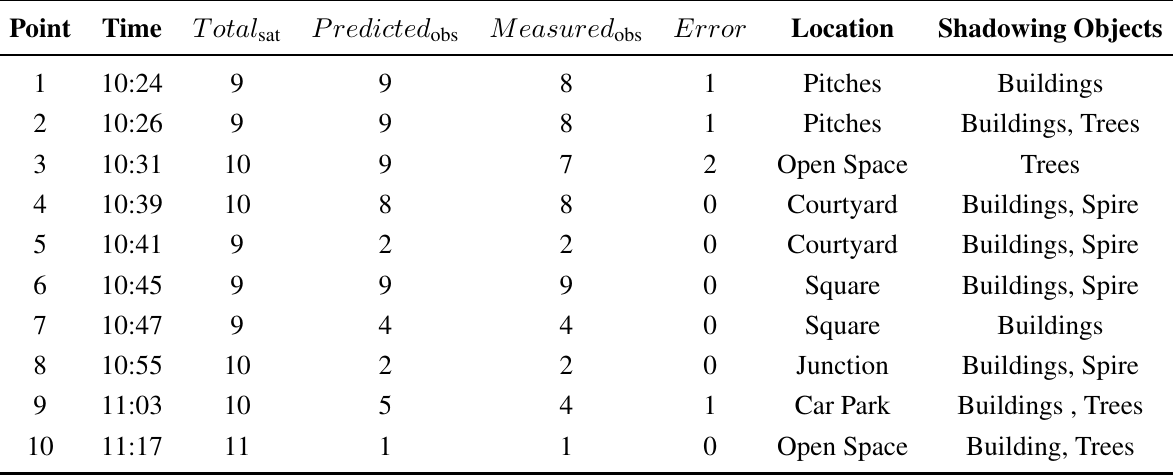
Table 2. GNSS prediction validation test results, description of site and shadowing objects.